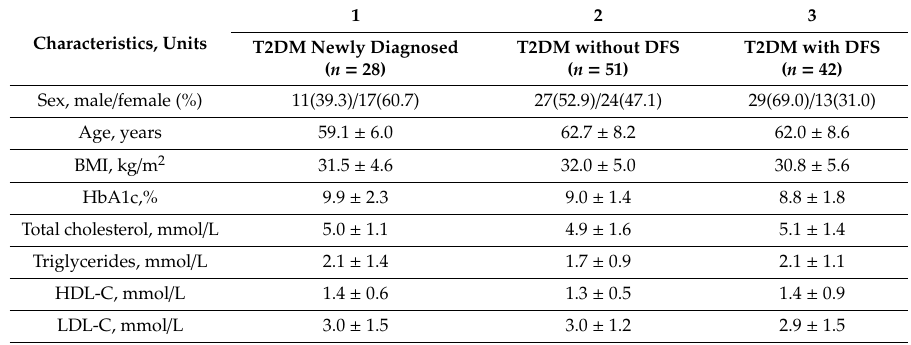
Table 1. Baseline characteristics of the examined patients with